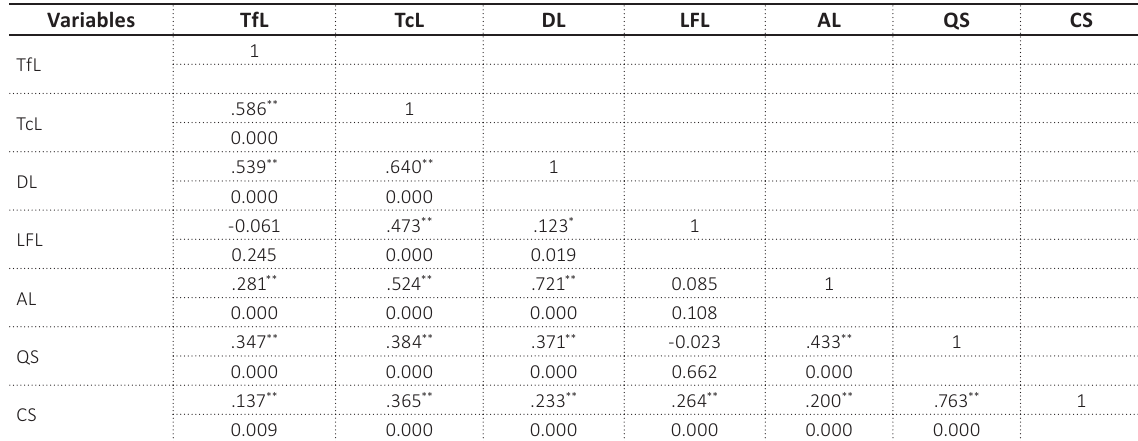
Table 4. Pearson correlation